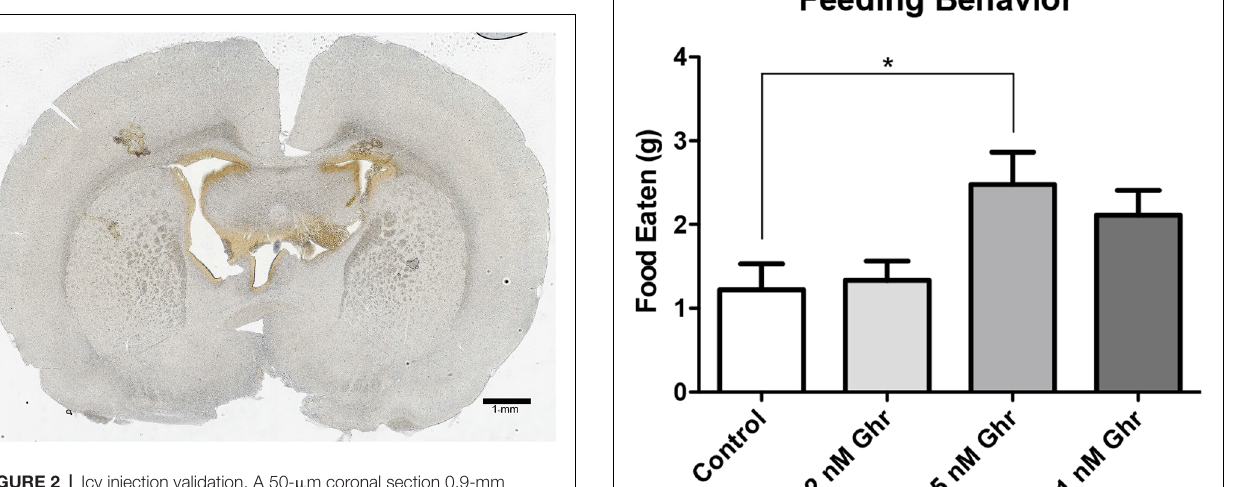
FIGURE 2 | Icv injection validation. A 50- µ m coronal section 0.9-mm posterior from Bregma was imaged to show the site of icv injection. The lateral ventricles were located 1.5-mm lateral from Bregma (on both sides), and the injection was made at a depth of 3.6-mm from the surface of the brain. The hole-like structures in the central region of the section show the ventricle system, and the brown coloration is residue from a tryptophan blue control injection. The scale bar represents a length of 1-mm of brain tissue.